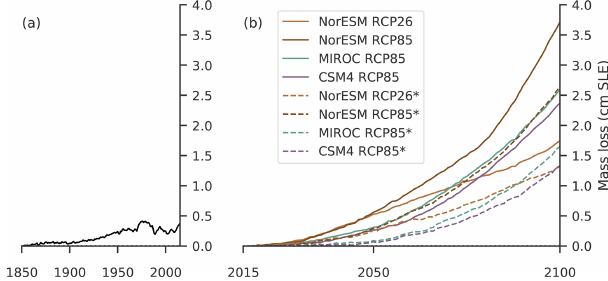
Figure 1. Historic simulation and projections of the Antarctic Ice Sheet driven by ISMIP6 ocean forcing. Shown is the evolution of the sea level contribution (a) for the historic simulation relative to its control simulation and (b) for the projections with respect to the control simulations, in centimeters of sea level equivalent (SLE). Experiments are initialized either from a historic run (solid lines) or from the initial state (dashed lines) and forced with changes in ocean temperature and salinity from ISMIP6 experiment nos. 1 to 4 with the respective CMIP5 model indicated in the